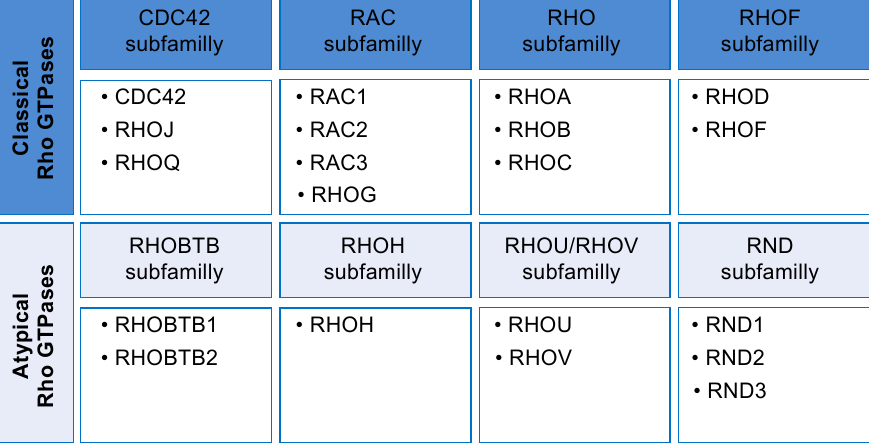
Figure 1. Rho GTPases classification in mammals. Rho GTPases are divided into eight subfamilies, namely the CDC42, RAC, RHO, RHOF, RHOBTB, RHOH, RHOU/RHOV, and RND subfamilies. These are further divided between classical and atypical Rho GTPases. Classical Rho GTPases cycle between an inactive GDP and an activate GTP-bound state while atypical Rho GTPases are mainly regulated through other mechanisms.